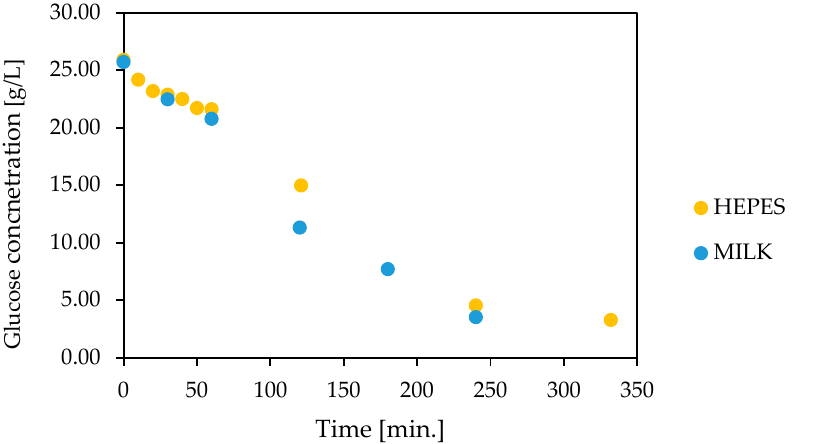
Figure 7. The comparison of glucose oxidase in lactose-free milk and HEPES buffer catalyzed by co-encapsulated glucose oxidase and catalase (GOX 2.7 g/L, CAT 0.43 g/L, capsules volume 3 mL, total volume 18 mL, 0.1 M HEPES pH 6.6, lactose-free milk pH 6.7, 12 °C, 1 M NaOH, compressed air 3 L/h).